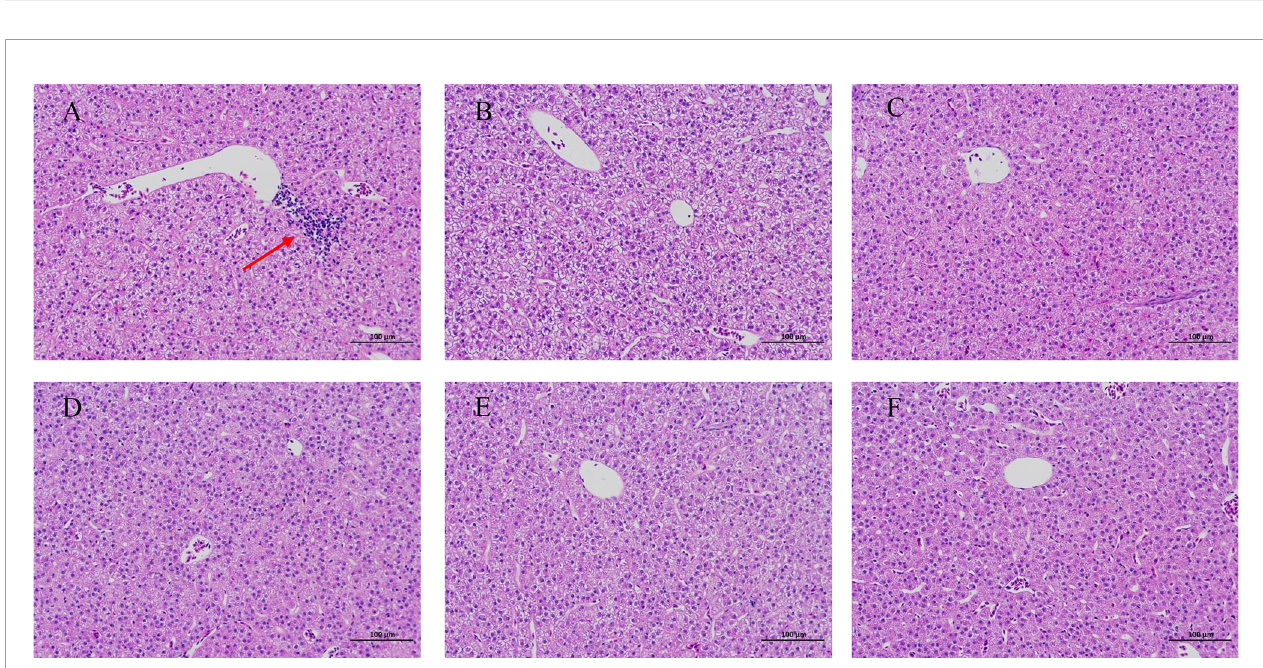
FIGURE 7 | The intestinal HE staining of juvenile blunt snout bream (200X). (A – F) were corresponding to 0%, 0.03%, 0.06%, 0.09%, 0.12% and 0.15% TB supplementation. The black arrow indicated that there was lysis and necrosis at the top of the intestinal villi, and the cell structure disappeared (A) ; a small number of intestinal villi fused with each other and the intestinal villi become wider (B, F) .